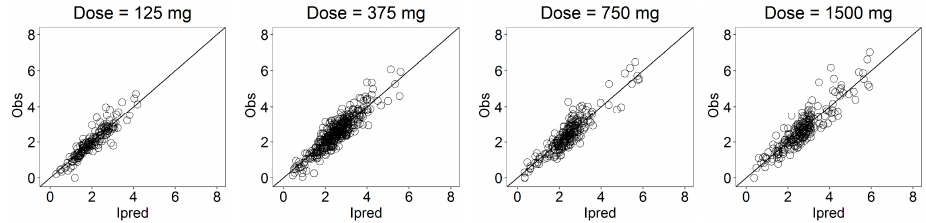
Figure 8. Goodness-of-fit plots for the serum concentration profile of progesterone stratified on the dose level.